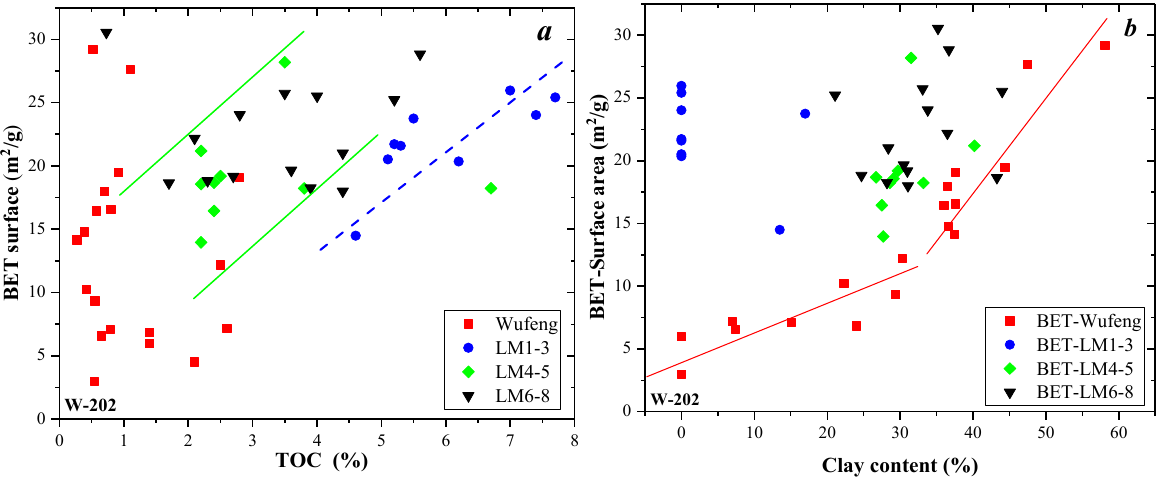
Figure 12. The correlation between the BET surface area and TOC content ( a ), clay mineral content ( b ) in the W202 well.